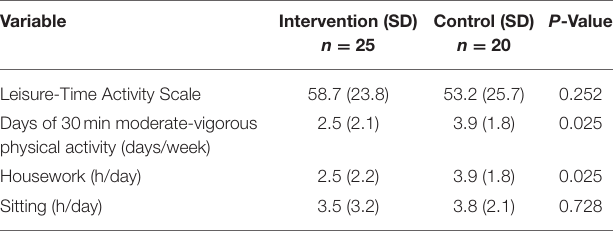
TABLE 3 | Baseline physical activity of participants in a dance-movement program.